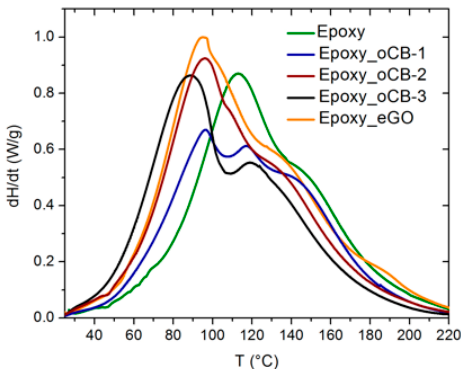
Figure 5. DSC scans (heating rate = 10 °C/min) for the pure epoxy resin ( green ) and for composite resins with 3 wt % of: oCB-1 ( blue ); oCB-2 ( wine ); oCB-3( black ); eGO ( orange ).